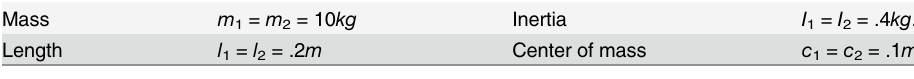
Table 1. Mechanical properties of the virtual double